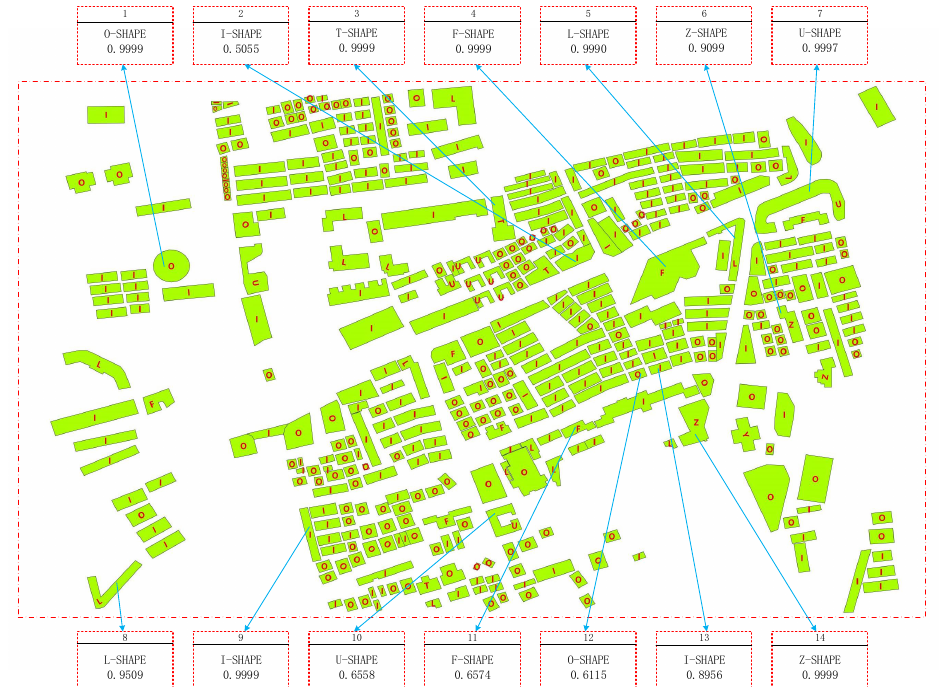
Figure 6. The predicted results of the buildings in the selected area of Figure 5, which is marked with the red